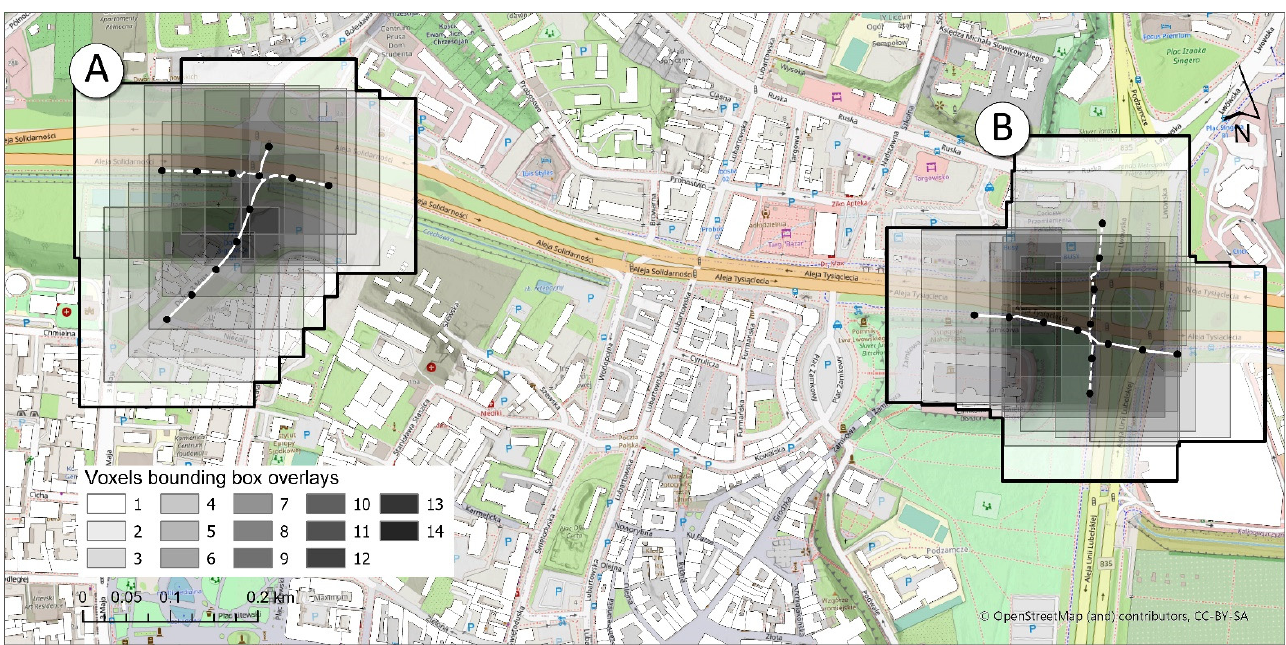
Figure 6. The spatial extent of the 3D ISOVISTS analysis in areas “A” ( A ) and “B” ( B ). The moving bounding box from one measurement point to the next (spaced 40 m) results in a bounding box overlay effect; the overlay border is an extent of the analysis.